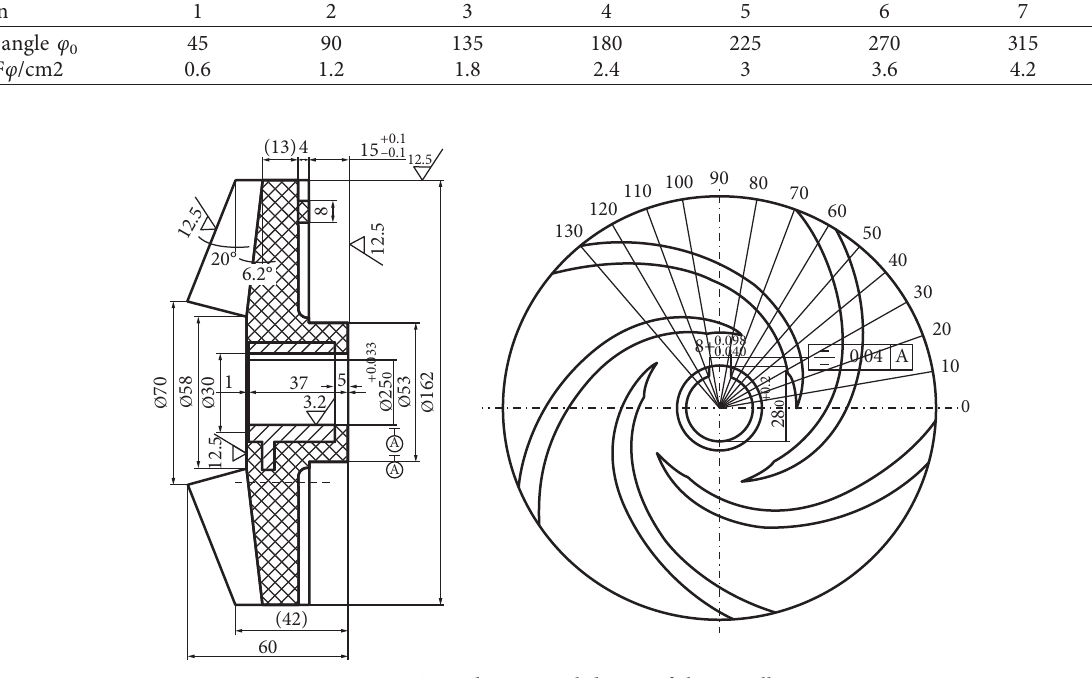
Figure 1: Two-dimensional design of the impeller.